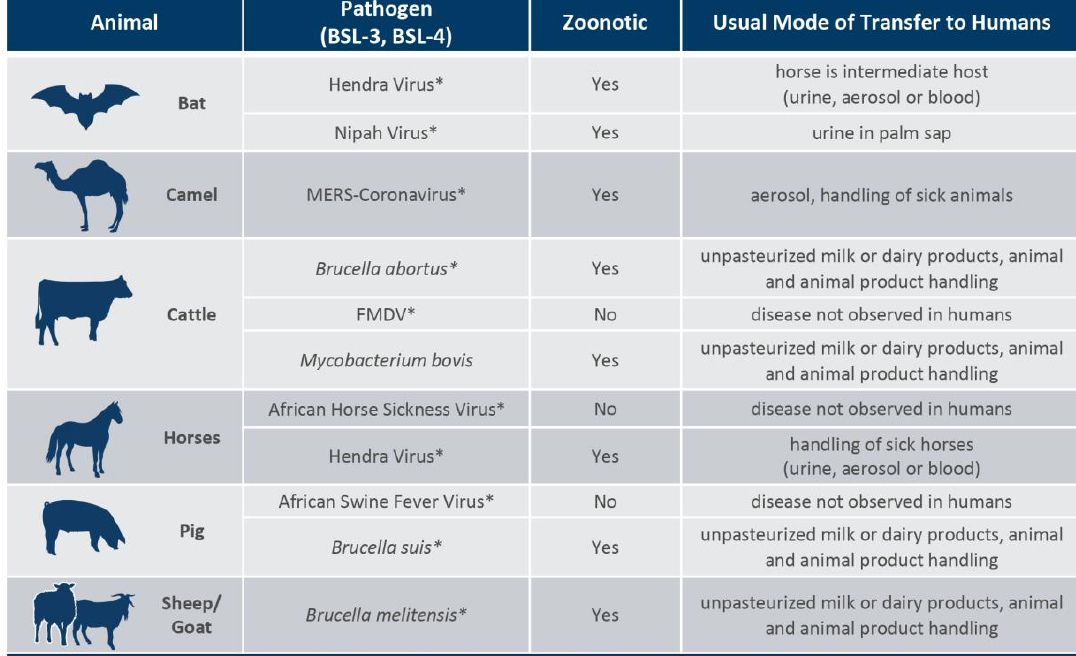
Figure 2. Both livestock and wild animals are impacted by zoonotic pathogens that require specialized BSL-3 or BSL-4 facilities. Several of the agricultural high-consequence pathogens discussed during this workshop are on the Select Agent list and many are also are infectious to humans (zoonotic).